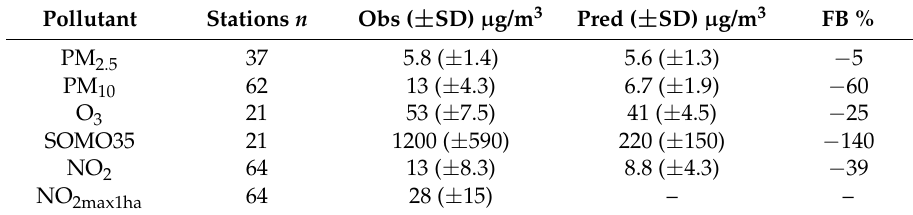
Table 3. Mean observed (obs) and predicted (pred) concentrations at monitoring stations and fractional bias (FB) of unadjusted predictions.